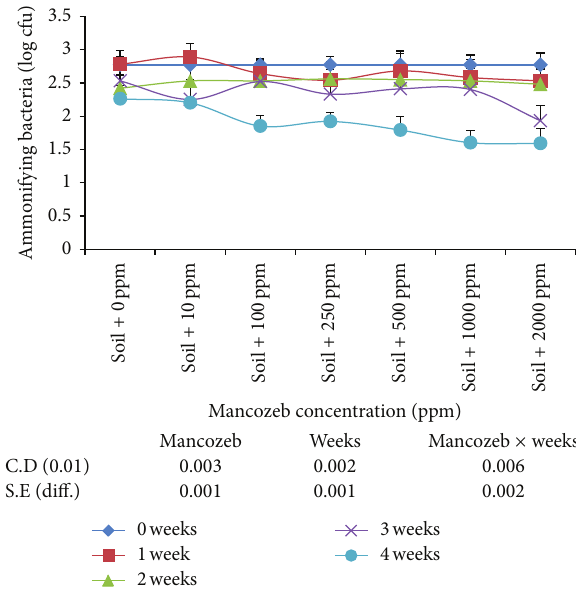
Figure 4: Effect of mancozeb on ammonifying bacterial